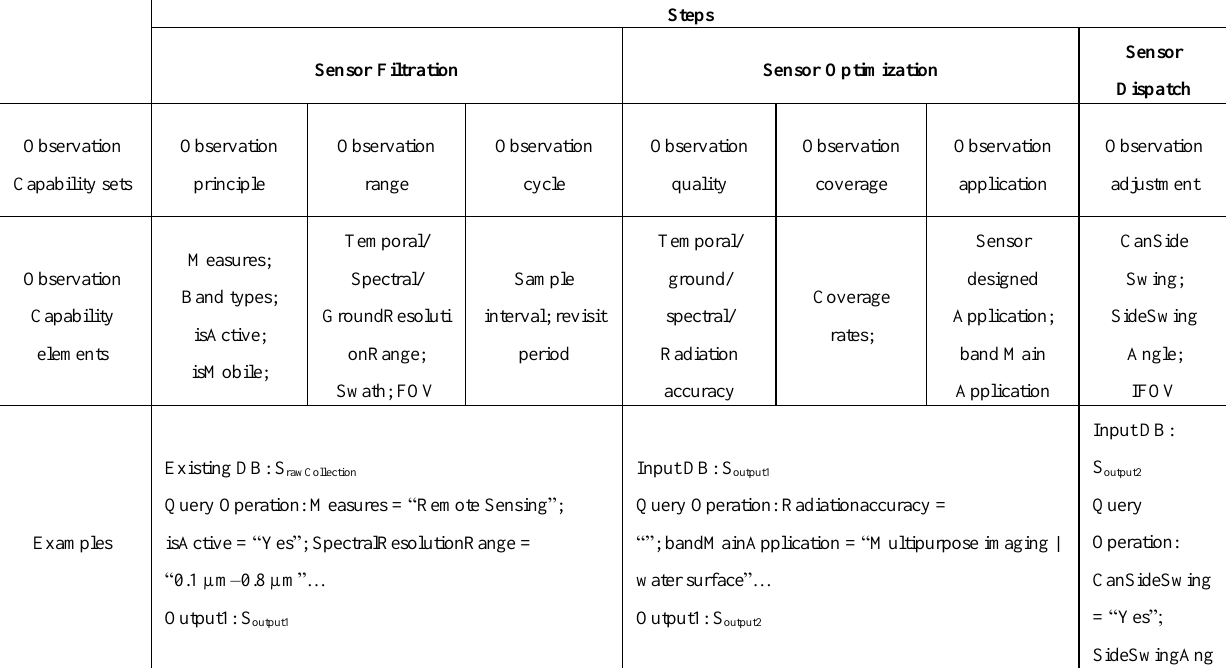
Table 1. Steps for sensor collaborative planning scenarios. IFOV, instantaneous